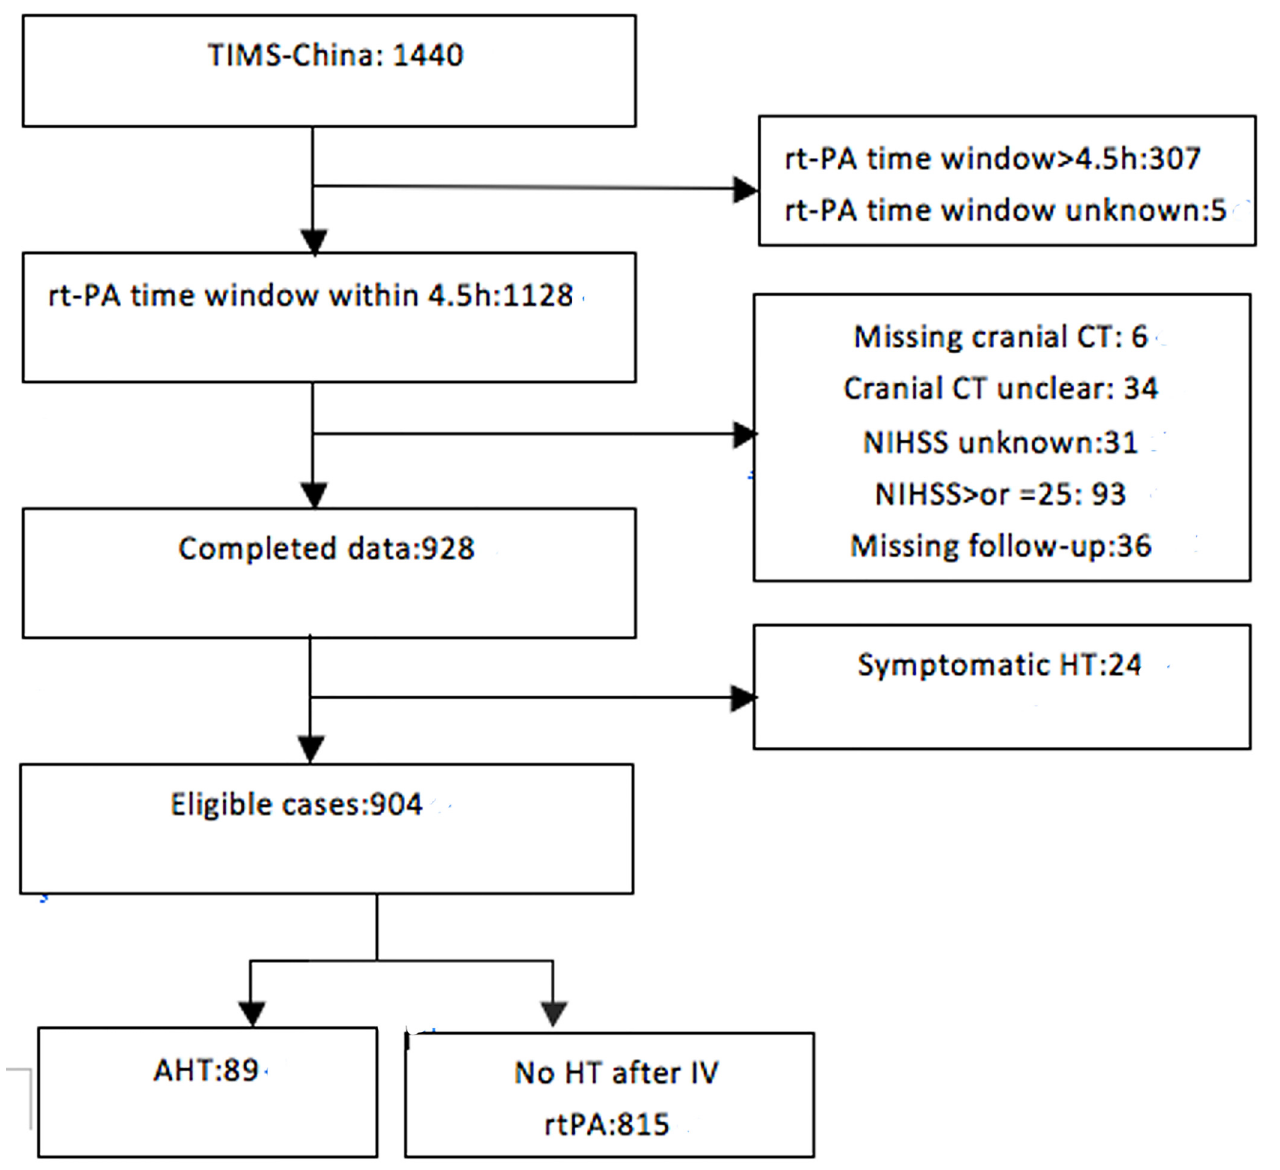
Fig 1. Numbers of eligible patients in